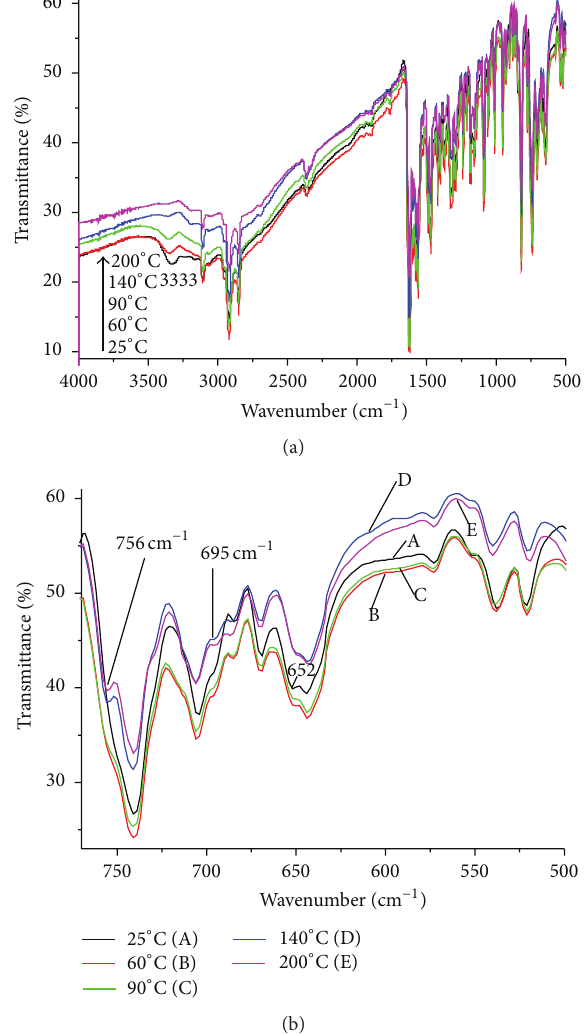
Figure 1: The IR spectra of compound 2 on heating in the whole spectra range investigated (a) and in the narrowed range